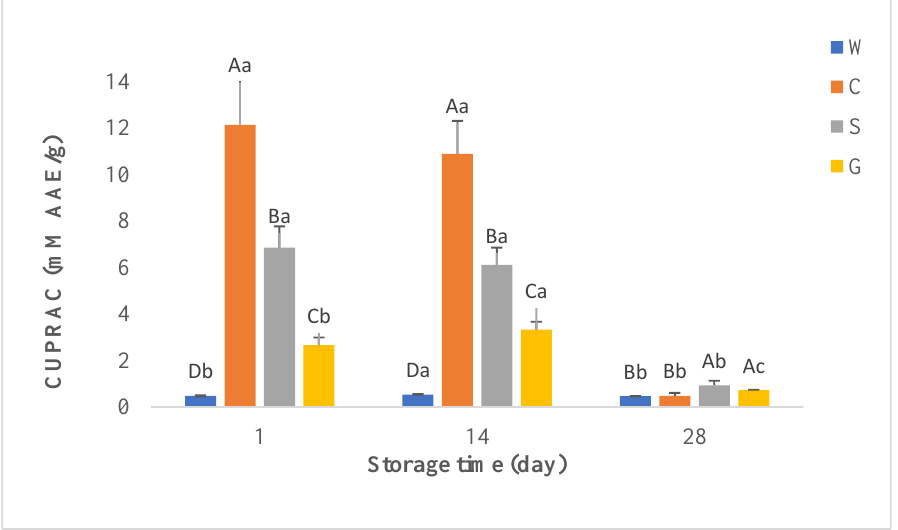
Figure 3. DPPH (mM AAE/g) in probiotic fermented whey beverages enriched with kiwi powder. a–c Means ± standard deviations in the same beverage group with different superscript lowercase letters are significantly different ( p < 0.05); A–D Means ± standard deviations in the same storage day with different superscript uppercase letters are significantly different ( p < 0.05). C = probiotic fermented beverage produced from cow WPC and enriched with kiwi powder, G = probiotic fer- mented beverage produced from goat WPC and enriched with kiwi powder, S = probiotic fermented beverage produced from sheep WPC and enriched with kiwi powder, W = probiotic fermented beverage produced without WPC and enriched with kiwi powder.